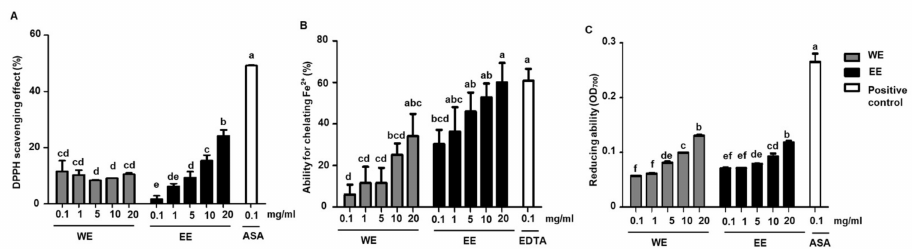
Figure 1. Antioxidant abilities of water extract (WE) and ethanol extract (EE) of L. rhamnosus fer- mented soymilk in vitro. The scavenging effect of DPPH radicals ( A ); The ability for chelating Fe 2+ ( B ); The reducing activity ( C ). Data presented as means ± SEM ( n = 2). Bar values with different letters were significantly different by Duncan’s multiple range test ( p < 0.05). ASA: Ascorbic acid; EDTA: Ethylenediaminetetraacetic